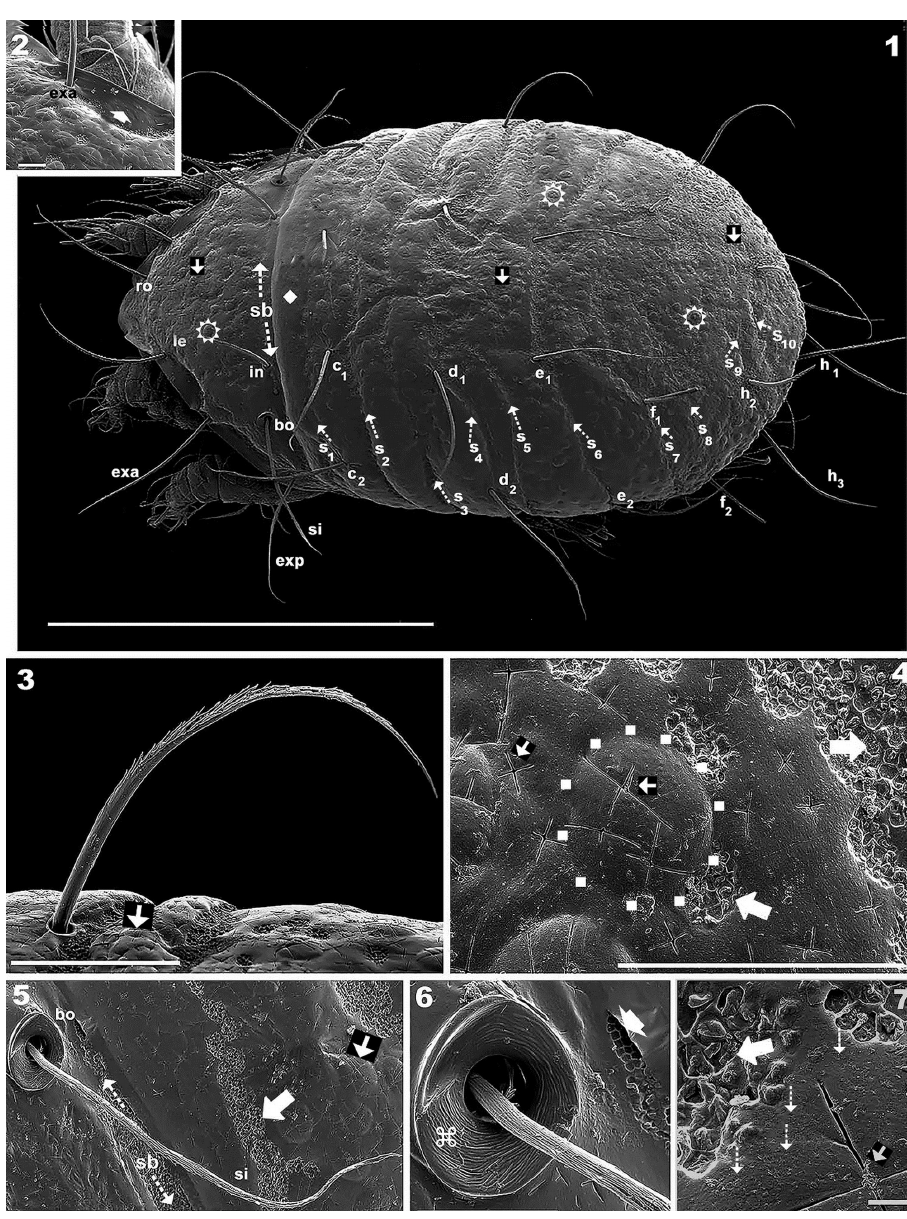
Figures 1–7. Meristacarus perikopesis sp. n. Adult with cerotegumental layer. SEM micrographs. 1 dorsal view 2 dorsal prodorsal margin 3 notogastral setae, lateral view 4 cuticular microsculpture 5 sensillus, general view 6 bothridium detail 7 cuticular microsculpture, high magnification. Abbreviations: See “Ma- terial and methods”. Scale bars: 500 μm ( 1 ); 20 μm ( 2 ); 50 μm ( 3 ); 30 μm ( 4 ); 100 μm ( 5 ); 6 20 μm ( 6 ); 2 μm ( 7